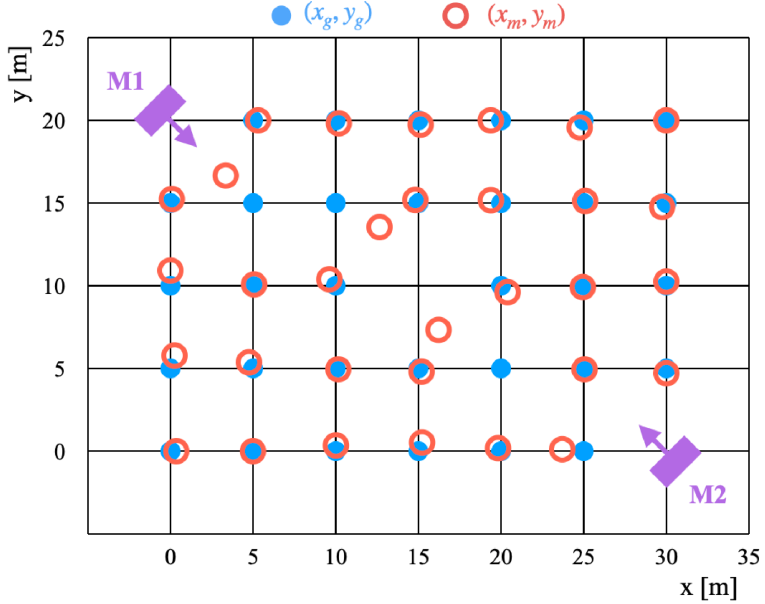
Figure 17. Positional distributions between the GT positions and estimated positions for Experiment C.